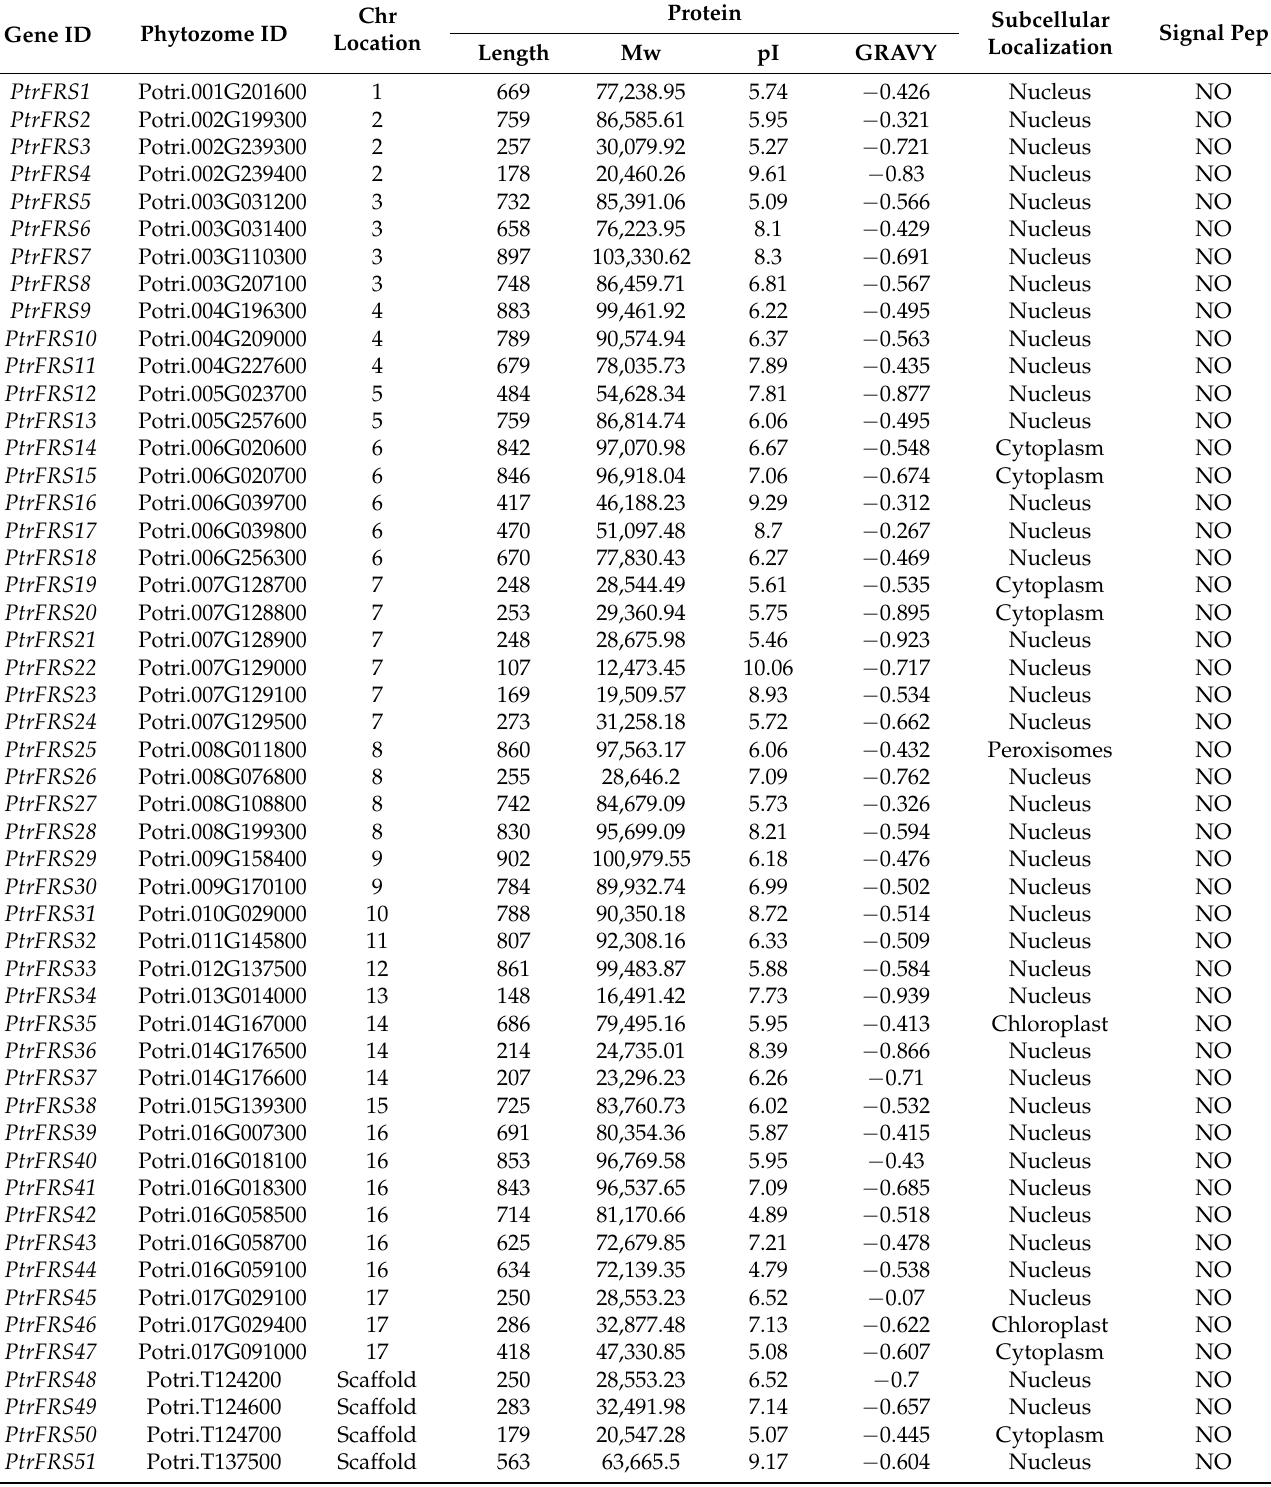
Table 1. Information of PtrFRS